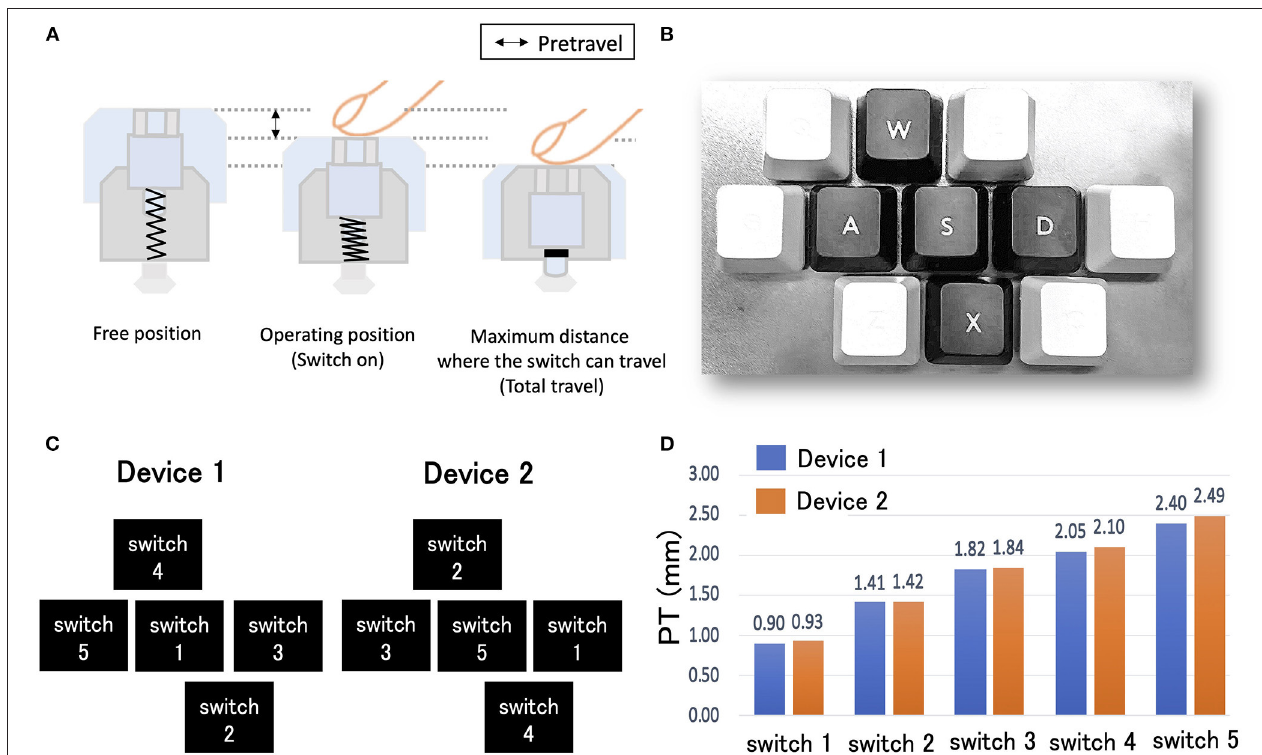
FIGURE 1 | (A) Schematic explanation of pre-travel (PT) value of a mechanical keyboard switch. PT represents the distance from a free position to an operating position of a switch. (B) An image of the experimental device. The five experimental switches were set on the metallic board. The arrangement of the experimental switches follows the positions of A, S, D, W, and X of a commercially available keyboard. (C) To avoid the potential confounding effect of switch position on ERP amplitudes, two experimental devices were prepared with the experimental switches set at different positions. In both devices, the experimental switches 1, 3, and 5 were set in the horizontal positions (i.e., A, S, and D positions); and switches 2 and 4 were set in the upper or lower positions (i.e., W and X positions). (D) PTs of the five experimental switches in devices 1 and 2. The PTs of both devices increased linearly from Switch 1 to